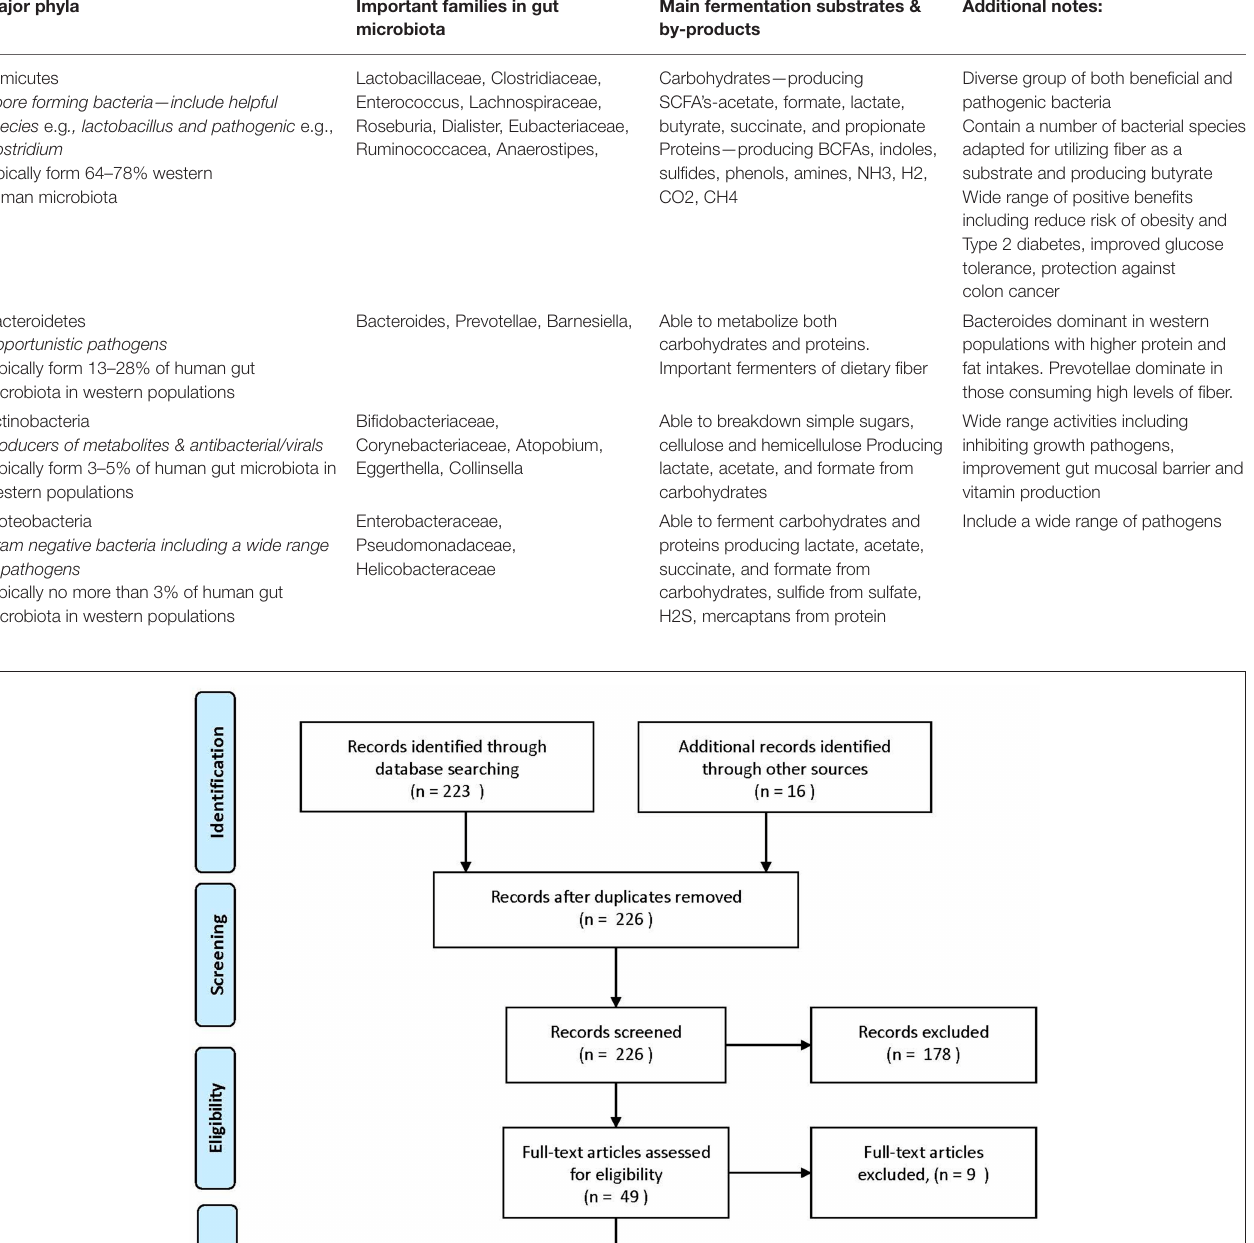
TABLE 1 | Major Bacterial Groups in the Human Gut Microbiota and the Main Fermentation Products.